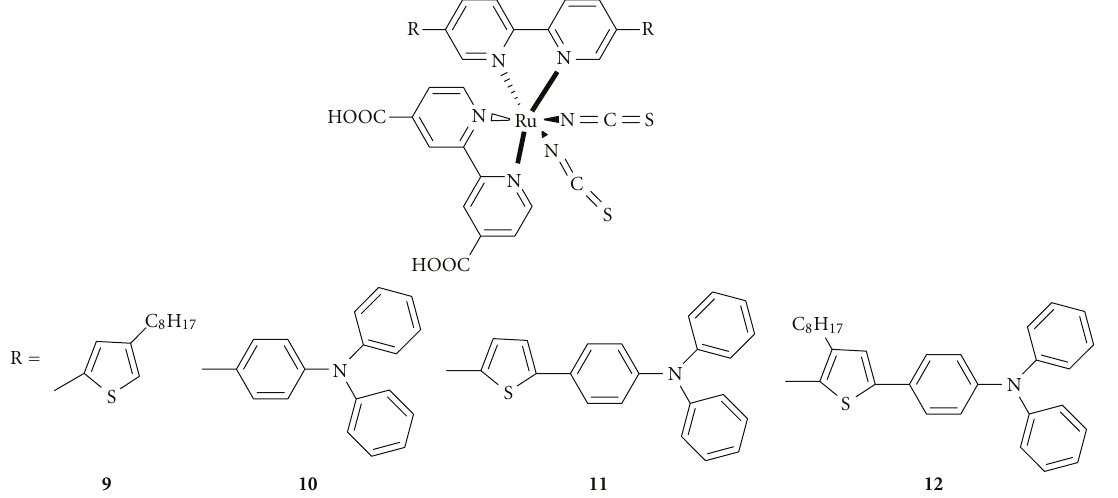
Figure 27: Molecular structures of ruthenium-based sensitizers 9–12 (taken from